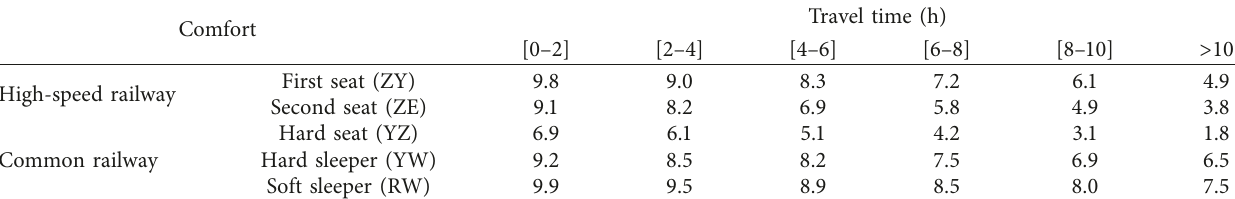
Table 1: Costs of comfort